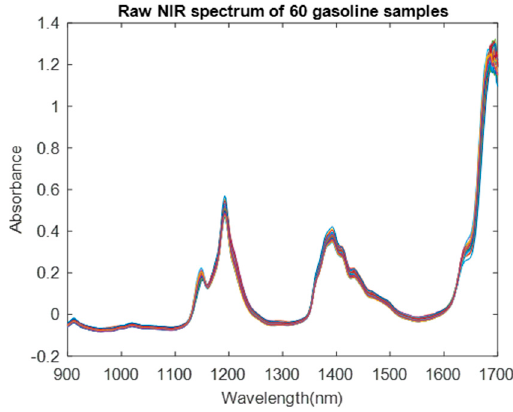
Figure 4. Raw spectrum of 60 gasoline samples.